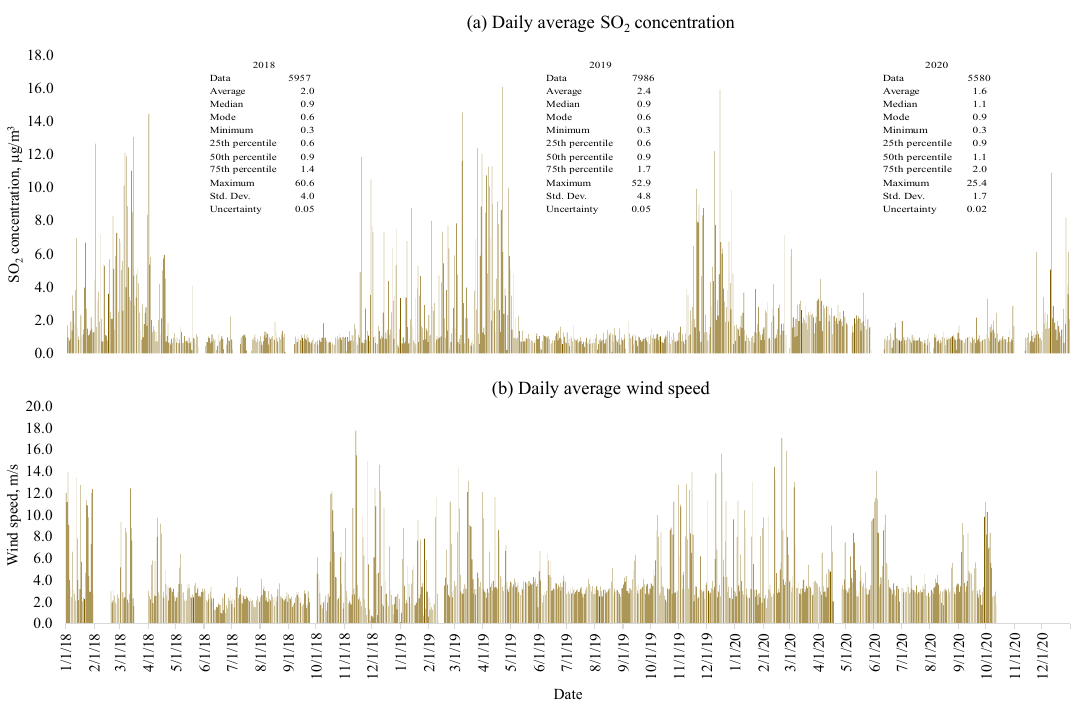
Atmosphere 2022 , 12 , x FOR PEER REVIEW Figure 6. AQMS recording for ( a ) SO 2 ambient concentration and ( b ) wind speed from 2018 to 2020. SO 2 analysis with respect to the meteorological data was performed using SO 2 tem- poral profiles, wind speed, and direction from AQMS. Figure 7a shows the highest SO 2 concentration occurred when the wind came from an ESE direction with 4 m/s. The wind speed is highest in the NNW, N, and NNE directions of 5 m/s to 9 m/s. The lowest con- centrations were measured with the wind coming from NE to WNW, with speeds of ap- proximately 2 m/s. According to the database from AQMS (Figure 7b), over 1000 were N (frequency of 14%) and W (frequency of 14%); however, the SO 2 concentrations were min- imal (1.5 µg/m 3 ) in those directions. There is no significant contribution from S compo- nents. The E and ESE directions occurred 10% of the time and ranged from 4 µg/m 3 to 5.5 µg/m 3 SO 2 concentrations prevail in those components.